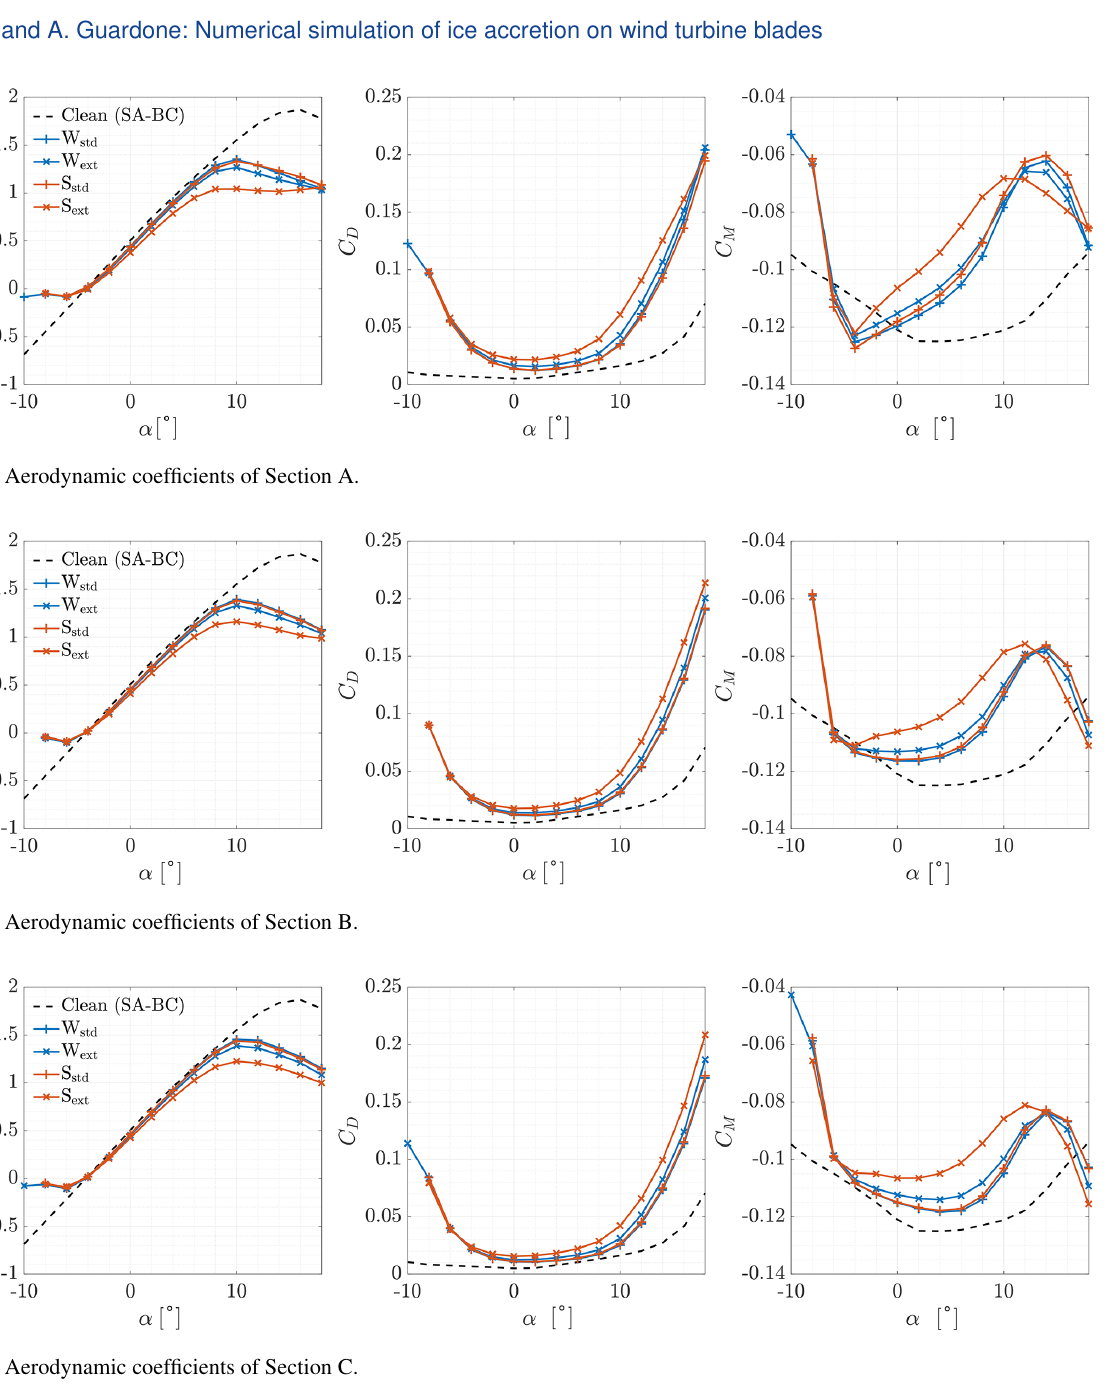
Figure 19. Aerodynamic coefficients of Section